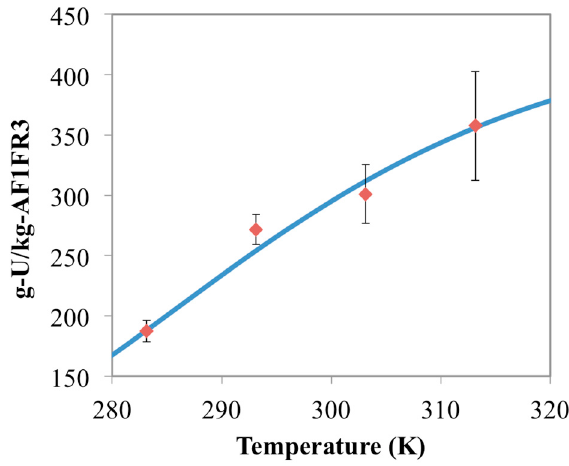
Figure 4. Comparison between chemisorption model results (blue line) and the AF1FR3 experimental data (red diamonds) for 10 mg of adsorbent material. Error bars represent two standard deviations of the data.